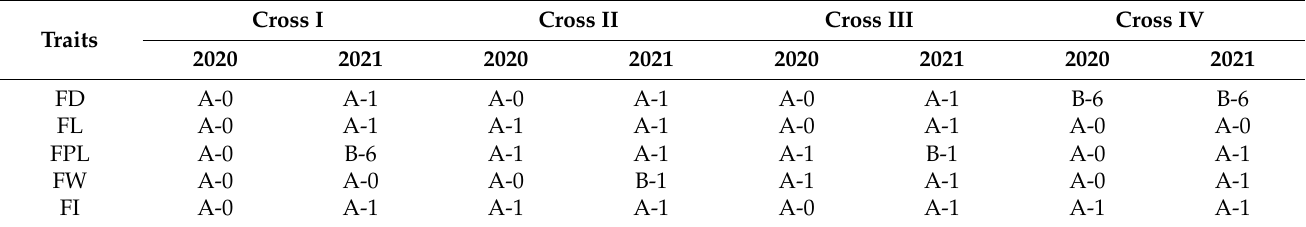
Table 5. Optimum genetic model for five main fruit